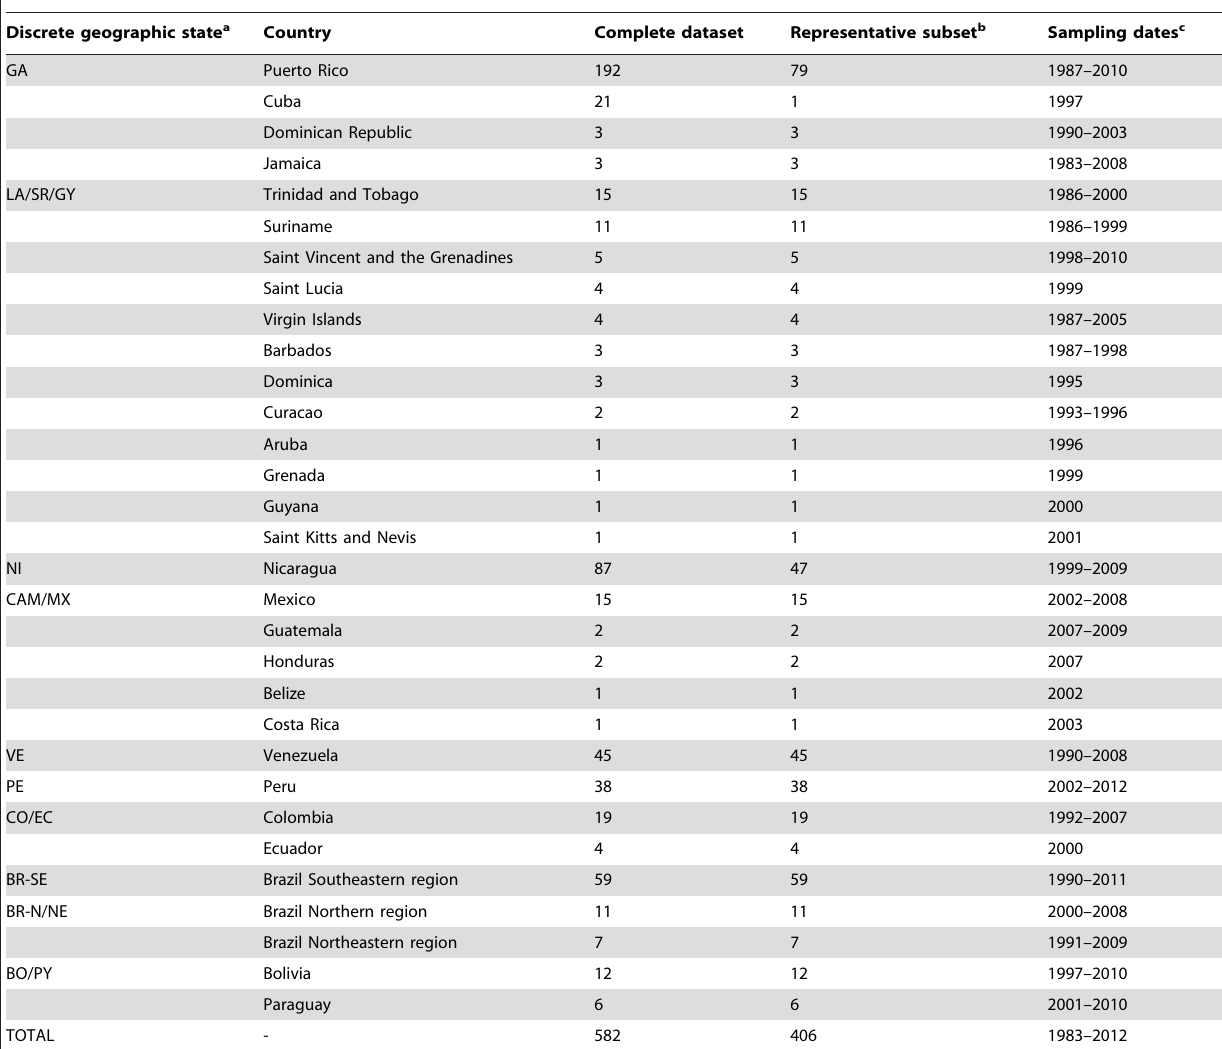
Table 2. DENV-2 AS/AM genotype sequences of American origin.